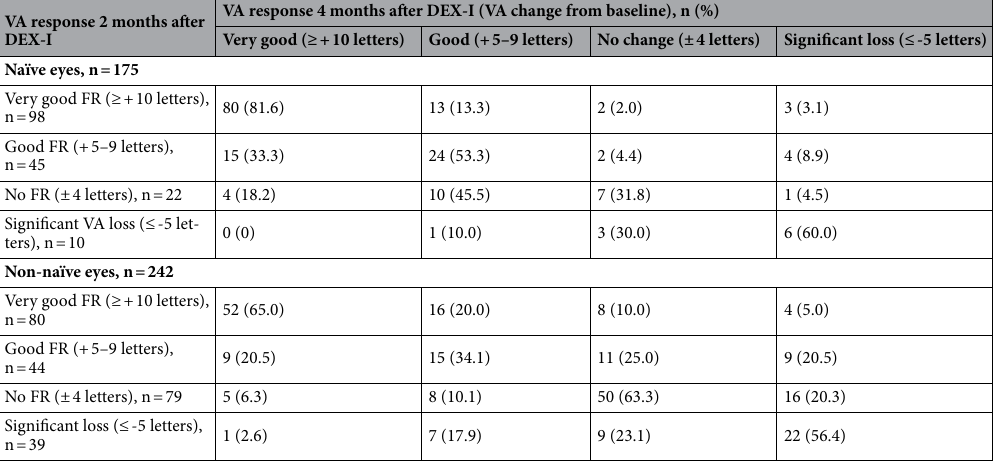
Table 3. Functional response at 4 months stratified for VA response after 2 months. DEX-I—Dexamethasone implant, FR—Functional response, VA—Visual